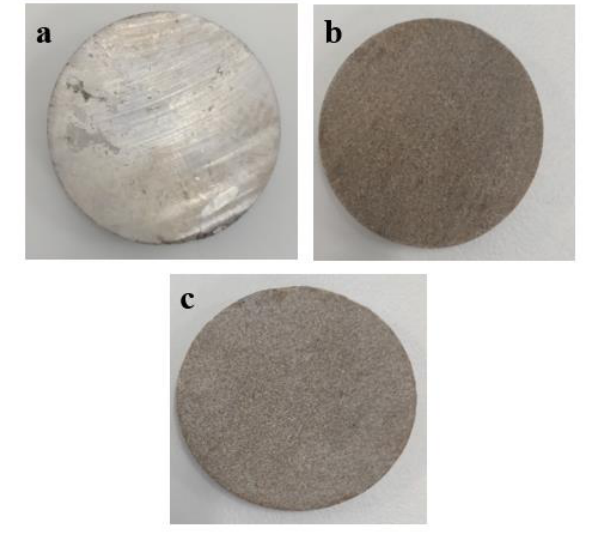
Fig. 1. Cross sectional images of tight gas samples, (a) X (b) Y (c) Z